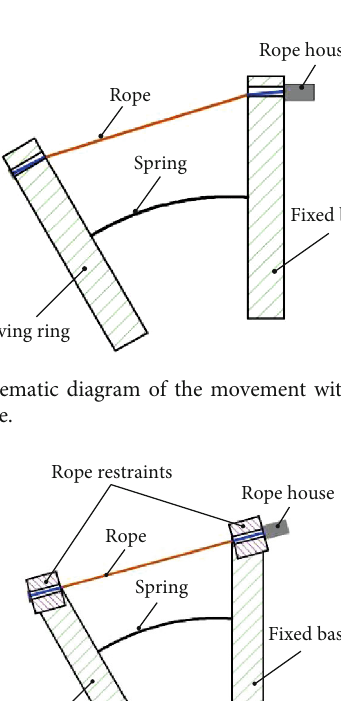
Figure 5: Distribution and movement form of the cable restraint device.